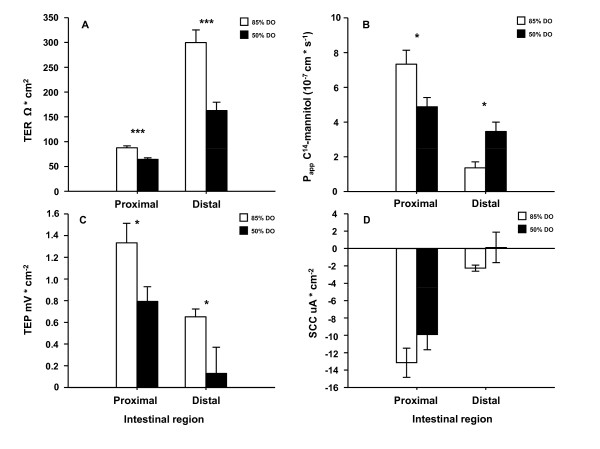
Intestinal barrier function after long term hypoxia at high temperature (Experiment 2). This experiment aimed at mimicking DO levels measured in sea cages in fjords sheltered from waves, wind and strong currents. In these situations, cyclic drops in DO levels are frequently observed during slack water at tidal reverse and further decreased DO levels are observed during high temperatures. Four oxygen treatment regimes were initiated: fixed 50% or 85% DO levels, or 50% or 85% DO levels in two different 6 hour cycles (4:2 h at 85:50%; 1:5 h at 85:50%) at 16°C. Four fish per tank from fixed 85% and 50% DO groups were sampled. The intestine was removed and opened longitudinally, divided into a proximal and a distal part, washed in ice-cold salmon Ringer solution and mounted in Ussing chambers. The electrical parameters; transepithelial resistance (TER), short-circuit current (SCC) and transepithelial potential (TEP) were measured. TER is mainly a measure of the paracellular permeability, and SCC describes the sum of active transports. This, together with the passive leakage of charged molecules across the epithelium is reflected in the TEP. Ussing chamber data was analysed in a genral linear model with intestinal region and treatment (with tank nested within treatment) as factors. The paracellular permeability of the intestinal epithelium was also assessed as the apparent permeability (Papp) of 14C-mannitol. TER was lower in the 50% DO group in both intestinal regions (p < 0.001) (A). An interaction between intestinal region and treatment was found for Papp (p < 0.001), revealing a decrease in Papp of the proximal intestine whereas there was an increase in the distal region in the 50% DO group compared to the 85% DO group (B). In both proximal and distal intestine (p < 0.05) the capability to maintain a potential difference between mucosa and serosa was reduced as shown by decreased TEP (C). No differences in SCC could be observed between treatments in neither proximal nor distal intestine (D). All data are expressed as means ± SEM and p < 0.05 was regarded as significant and indicated as *, p < 0.01 as ** and p < 0.001 indicated as ***.